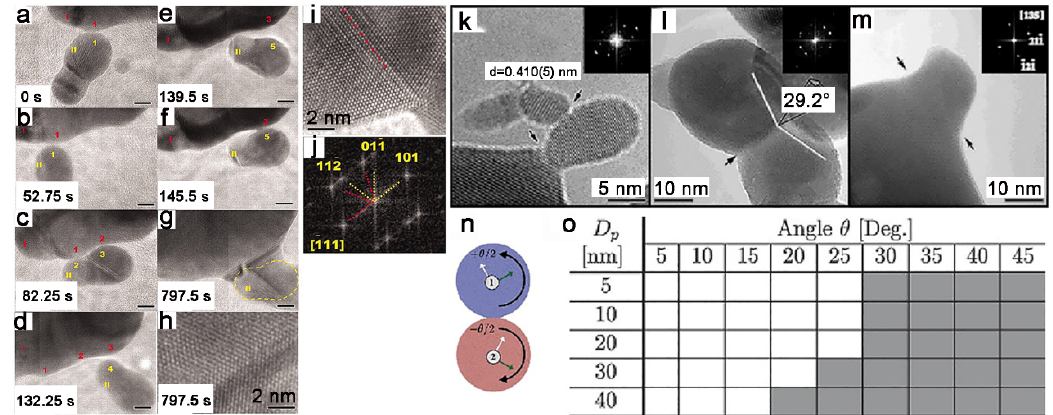
Figure 7. ( a – g ) Sequence of images showing typical dynamics of the oriented attachment (OA) process. ( h ) High-resolution image of interface in ( g ) showing twin structure (an inclined twin plane). The yellow dashed line in ( g ) shows the original boundary of the attached particle. ( i , j ) High-resolution in situ TEM image ( i ) and fast Fourier transform (FFT) ( j ) of an interface. The grain boundary is delineated by a dashed line in ( i ). Scale bars are 5 nm for (a) to ( g ). Reproduced with permission [94]. Copyright 2012, AAAS. ( k ) A small particle is attached to a bigger one without matching orientation. ( l ) Two particles have sintered together by building a boundary with a twin structure. ( m ) Two orientation matched particles have sintered together; the former shape is preserved. Reproduced with permission [86]. Copyright 2008, American Physical Society. ( n ) Atomistic simulation for a two-particle geometry, where two particles are rotated by an equal, but opposite angle, θ /2, about their common out-of-plane [001] crystal axis. ( o ) In a two-particle system, the particle diameters are Dp, the misorientation angles are angle θ , and the grain boundaries will not form in small misorientation angles (white cell) through rotation and will only form in large misorientation angles (gray cells). Reproduced with permission [87]. Copyright 2019, Elsevier B.V.